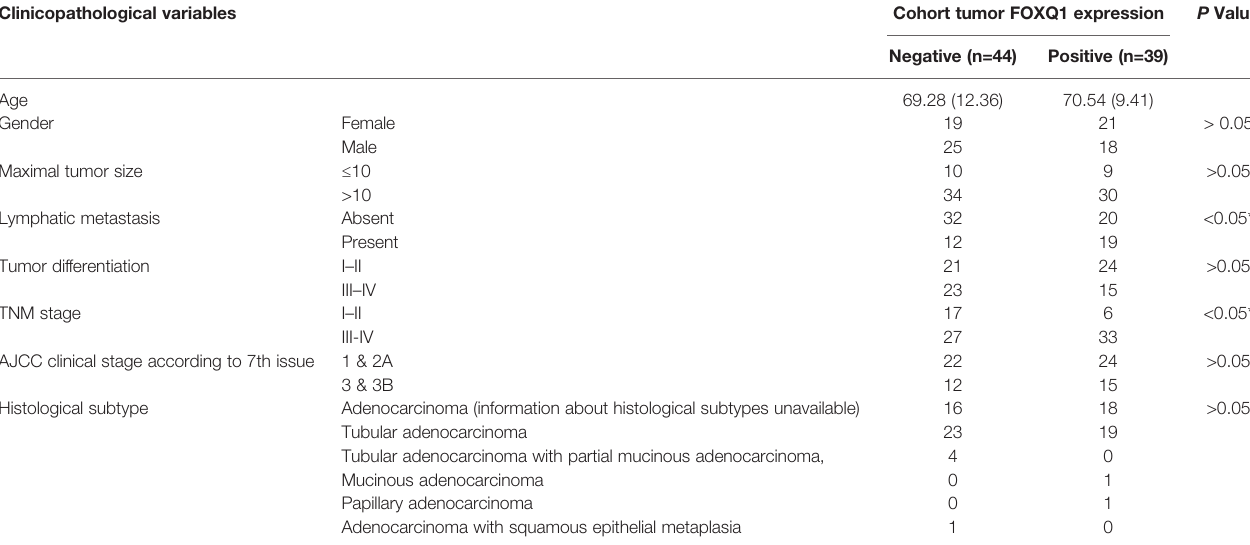
TABLE 1 | Correlation between FOXQ1 expression and clinicopathological characteristics of colorectal cancers (CRCs) in cohort of human CRC tissues. Clinicopathological variables